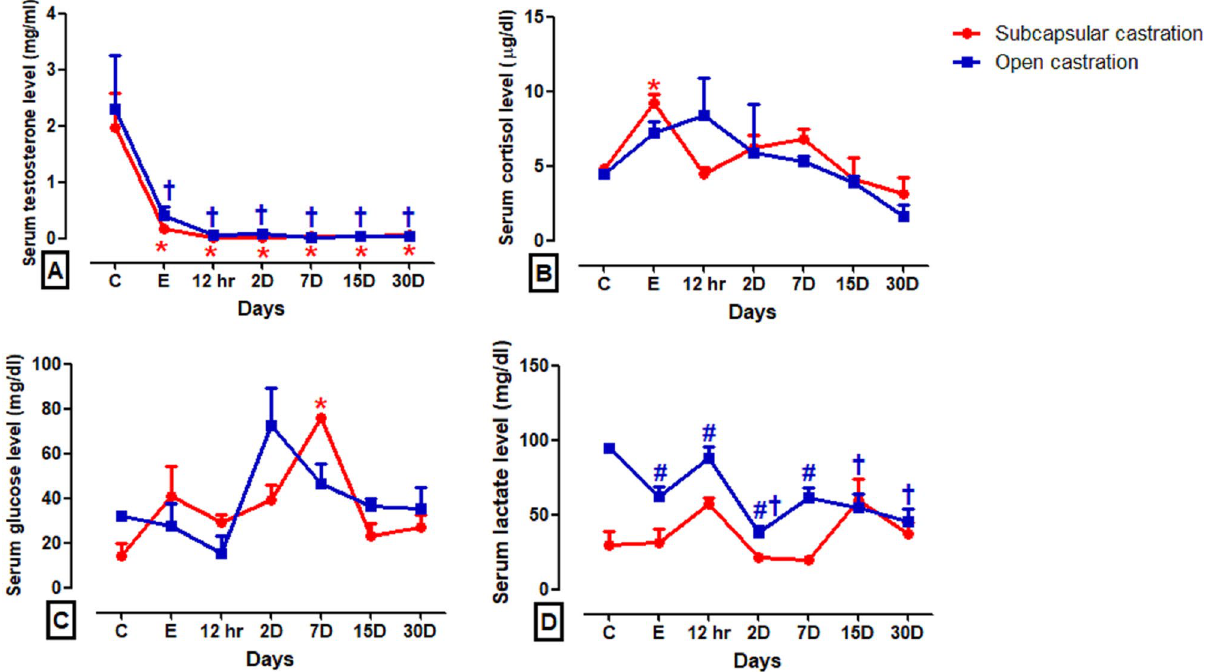
Figure 5. Serum concentrations of testosterone ( A ), cortisol ( B ), glucose ( C ), and lactate ( D ) in the subcapsular castration (SC) and open (OC) castration groups. # Indicates significant difference between different groups, *Indicate significant difference at different time intervals within the SC, † Indicate significant difference at different time intervals within the OC.